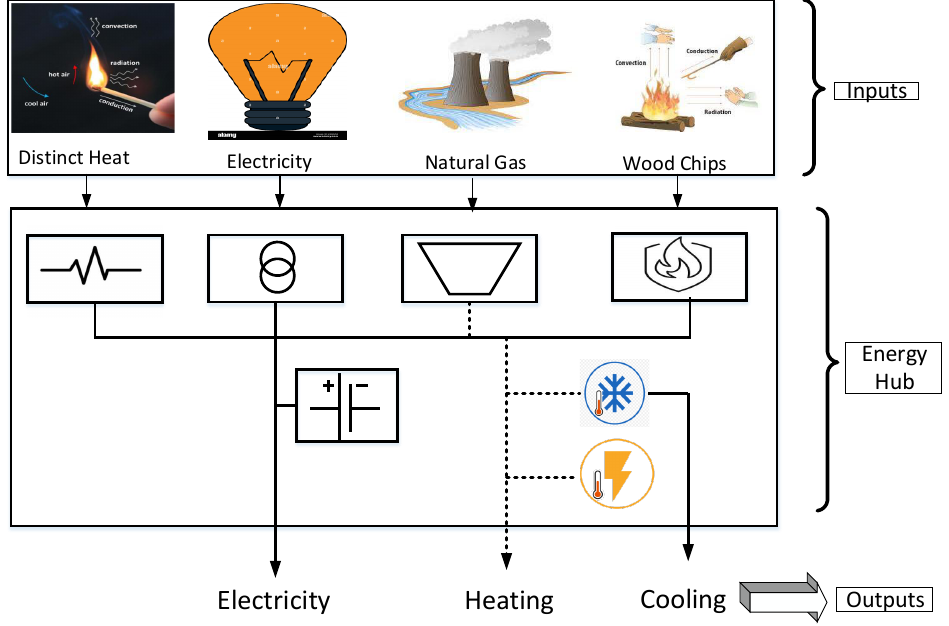
Figure 8. An energy hub concept